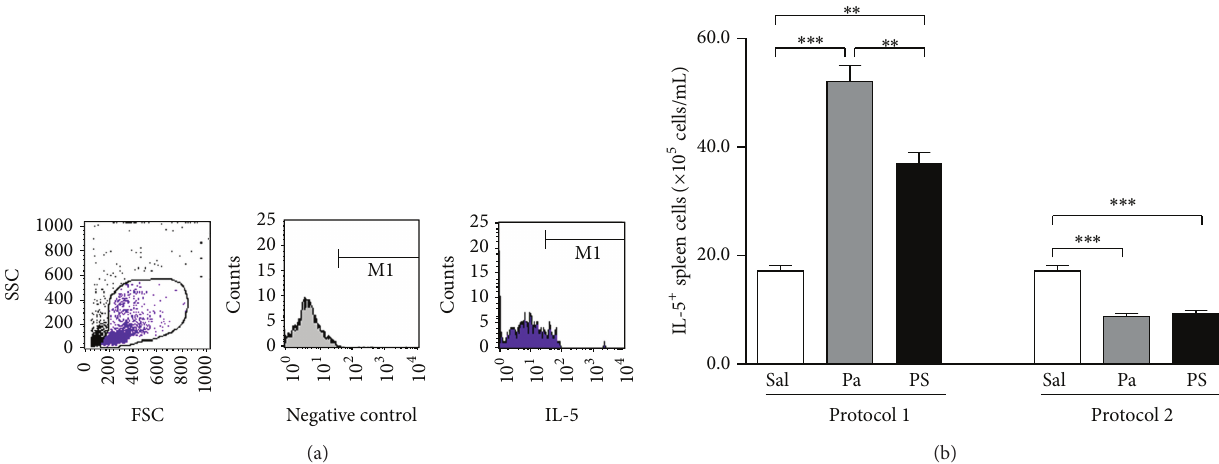
Figure 5: IL-5 synthesis by spleen cells. Spleen cells from mice treated with saline (Sal), P. acnes (Pa), or PS were obtained 14 days after HEW implantation and intracellularly stained with fluorochrome-conjugated monoclonal anti-IL-5 antibody. Percentages obtained by flow cytometric analysis (a) were converted to absolute numbers of IL-5 + spleen cells (b). ∗∗ 𝑃 < 0.01 ; ∗∗∗ 𝑃 < 0.0001 .